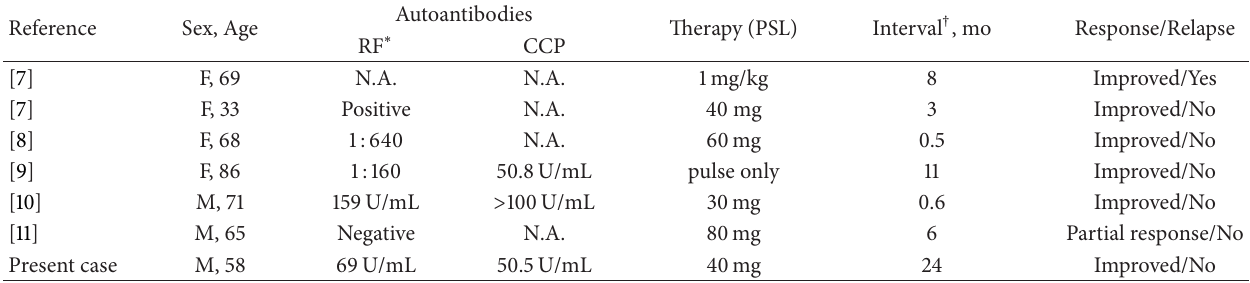
Table 1: Characteristics and outcome of seven patients reported in literatures.